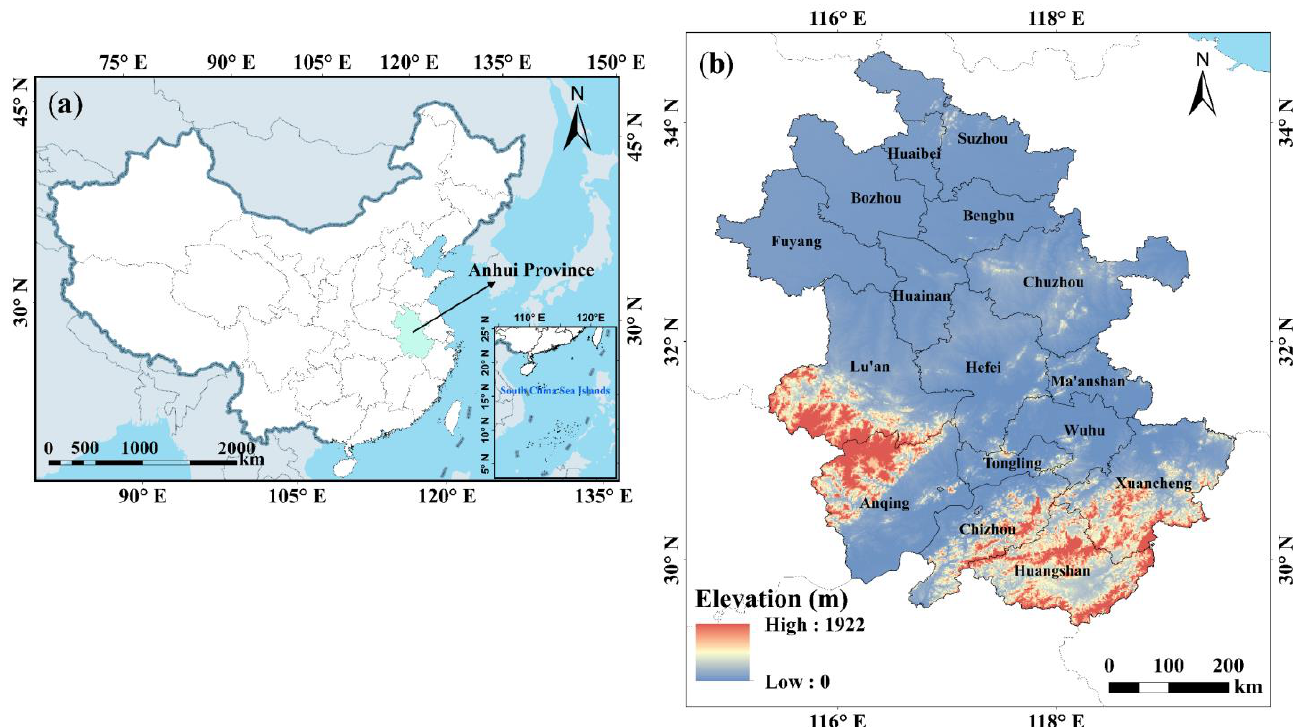
Figure 1. Study area: ( a ) location of Anhui province in China. ( b ) geographical map of Anhui province.